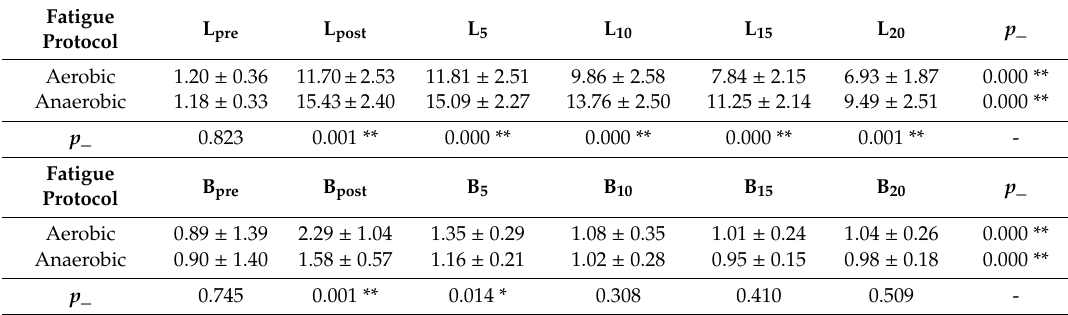
Table 1. Mean comparisons of participants with lactate and balance, which vary depending on aerobic and anaerobic loading. In horizontal, the repeated measures p values, in vertical the p values for aerobic vs. anaerobic